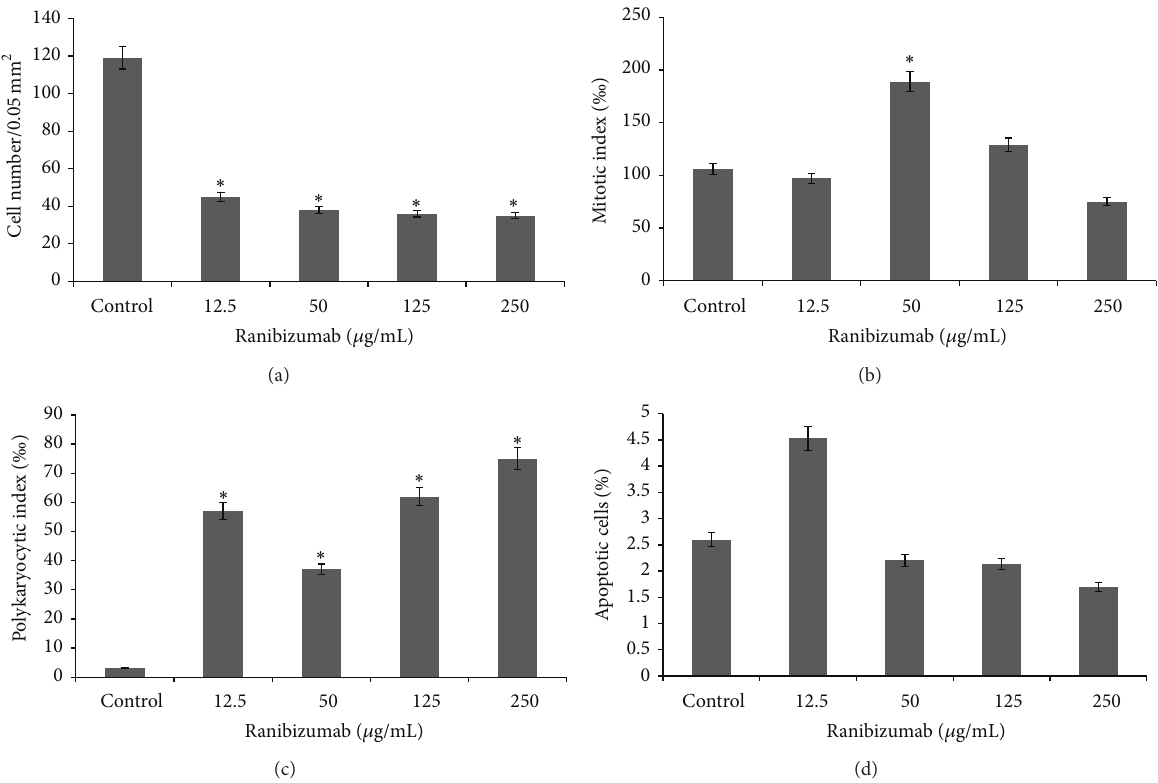
Figure 4: Kinetics of cellular proliferation (a), mitotic activity (b), polykaryocytic index (c), and apoptosis (d) in L929 cells treated by ranibizumab at different concentrations (data shown are at Day 5 of the treatment; 𝑛 = 3 , ∗ 𝑃 < 0.05